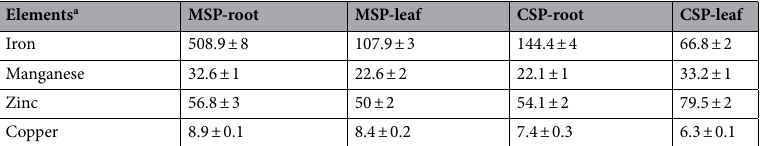
Table 3. Concentration (ppm or mg/kg-dry matter) of some major minerals including iron (Fe), zinc (Z), manganese (Mn), copper (Cu) in mass-selected variety (MSP) and cultivated spinach (CSP). a Each value is the mean of three replicate determinations ± standard